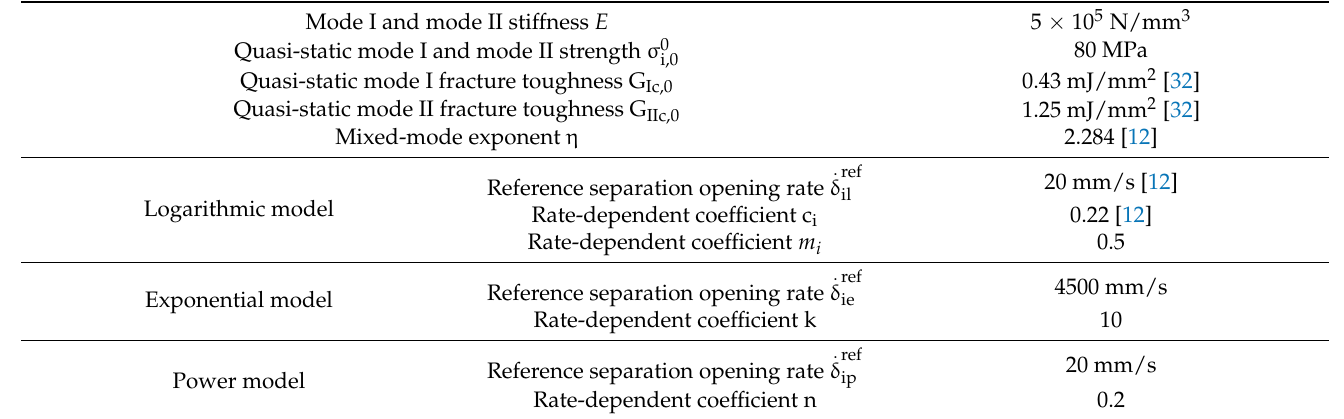
Table 2. Cohesive interface element properties of different